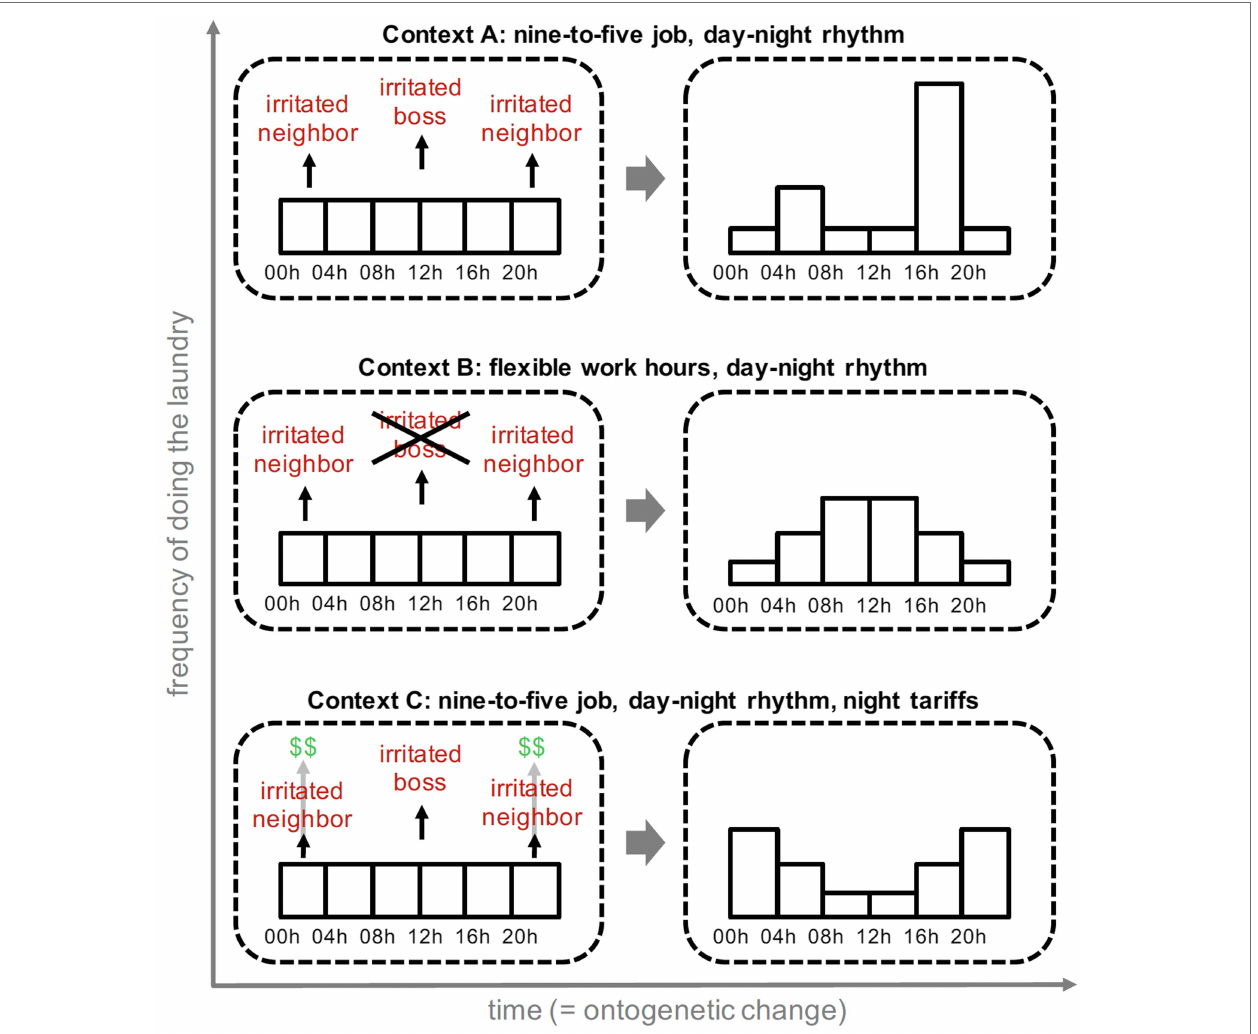
FIGURE 1 | Example of ontogenetic selection for doing laundry in three different contexts. Energy using behaviors (e.g., doing laundry) produce different consequences when performed at different times of the day. Critically, these consequences depend on the context of energy using behavior (e.g., the working hours of the individual; Wille, 2021). Context-dependent consequences select the behavior and, as a result, the distribution of energy using behavior changes over time (i.e., it adapts to the context; Wille, 2021). In some contexts (e.g., Context A), this may lead to an environmentally disadvantageous behavior distribution (i.e., evening peaks of household energy consumption when energy supply from renewable sources tend to be low). In order to approach such environmental issues, the perspective of behavior analysis suggests to modify the context in a way that behavior produces different consequences (i.e., to rearrange contingencies), so that the ontogenetic development of behavior can take a different direction. In Context B, for example, a context change (i.e., the flexibilization of work hours) entails that doing the laundry at noon does not lead to negative professional consequences (e.g., falling from favor with your employer, loss of earnings). With one of the main reasons for the evening peak in energy consumption being removed, behavior may become more evenly distributed across the day. Similarly, Context C involves a differential tariff structure that rewards doing the laundry at night. Implementation of such tariff structures can change how energy using behavior is selected and thus distributed across the day. It is noteworthy however that such tariff structures are unlikely to be as effective as suggested in this figure because of the dominating influence of other elements of the existing context (e.g., inflexible working hours; Wille,